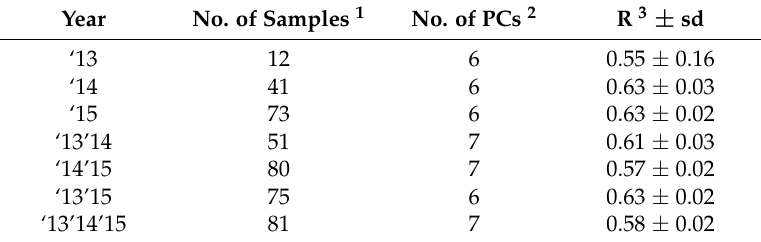
Table 12. Partial least squares regression models and their